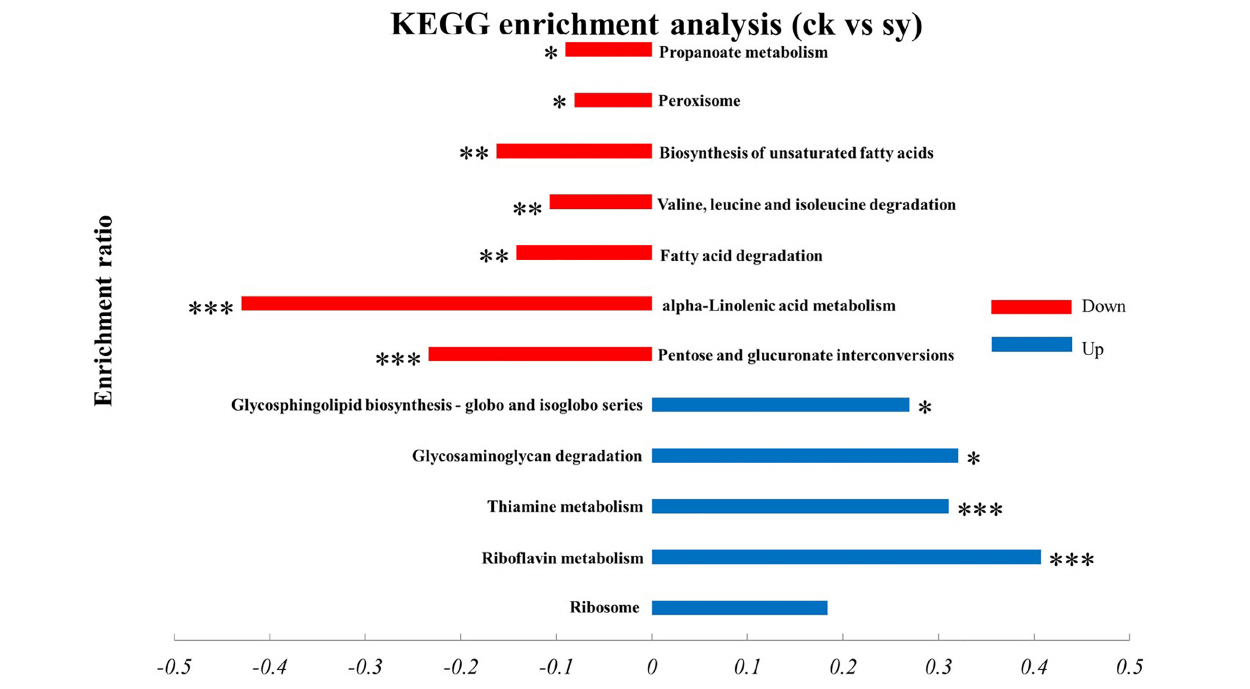
FIGURE 4 | KEGG enrichment analysis of DEPs in P. digitatum cells. * p < 0.05, ** p < 0.01, *** p < 0.001.